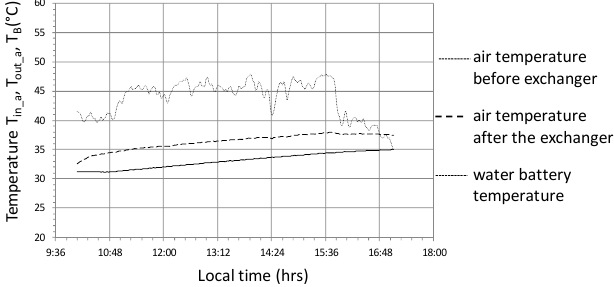
Figure 24. Timescale of temperature distribution in the heat storage system in the water accumulator for cycle No. 3.